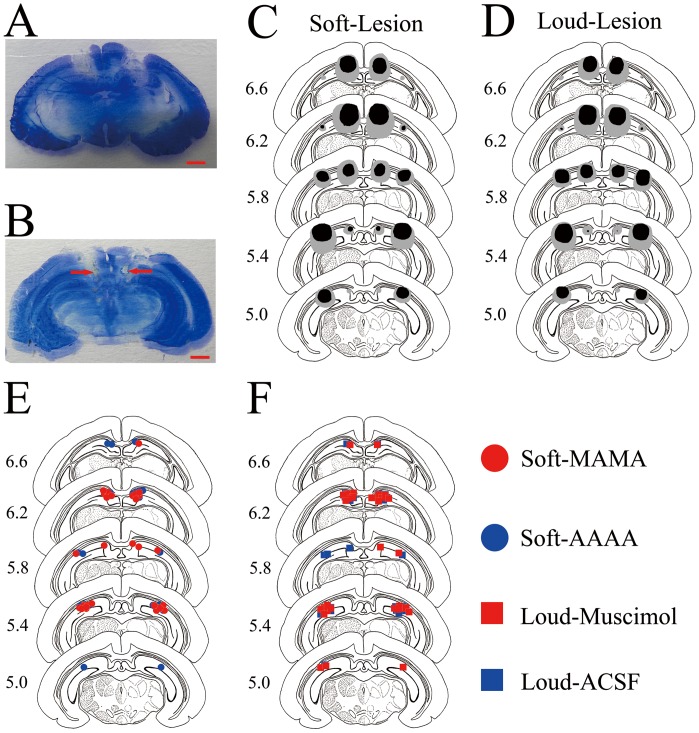
Histological reconstructions of the extents of electrolytic lesions and the placements of infusion cannula tips.(A, B) Two photomicrographs of two coronal sections showing a representative extent of electrolytic lesion of the dorsal hippocampus and a representative placement of infusion cannula tip in the dorsal hippocampus, respectively. Scale bars represent 2 mm. Red arrows indicate the locations of the infusion cannula tips. (C, D) The largest (gray shaded areas) and smallest (black shaded areas) lesions of the dorsal hippocampus in the Soft-Lesion (n = 7, C) and Loud-Lesion (n = 7, D) groups. (E, F) Schematic illustration of all infusion cannula tips placements in the Soft-MAMA (n = 8), Soft-AAAA (n = 8) (E), Soft-Muscimol (n = 8), and Soft-ACSF (n = 8) groups (F). A red circle, blue circle, red square, or blue square represents a placement of infusion cannula tip in the Soft-MAMA, Soft-AAAA, Soft-Muscimol, or Soft-ACSF group, respectively. Numbers to the left represent distance (mm) from the frontal zero plane. The coronal brain plates are adapted from the atlas of Rapisarda and Bacchelli (1977).